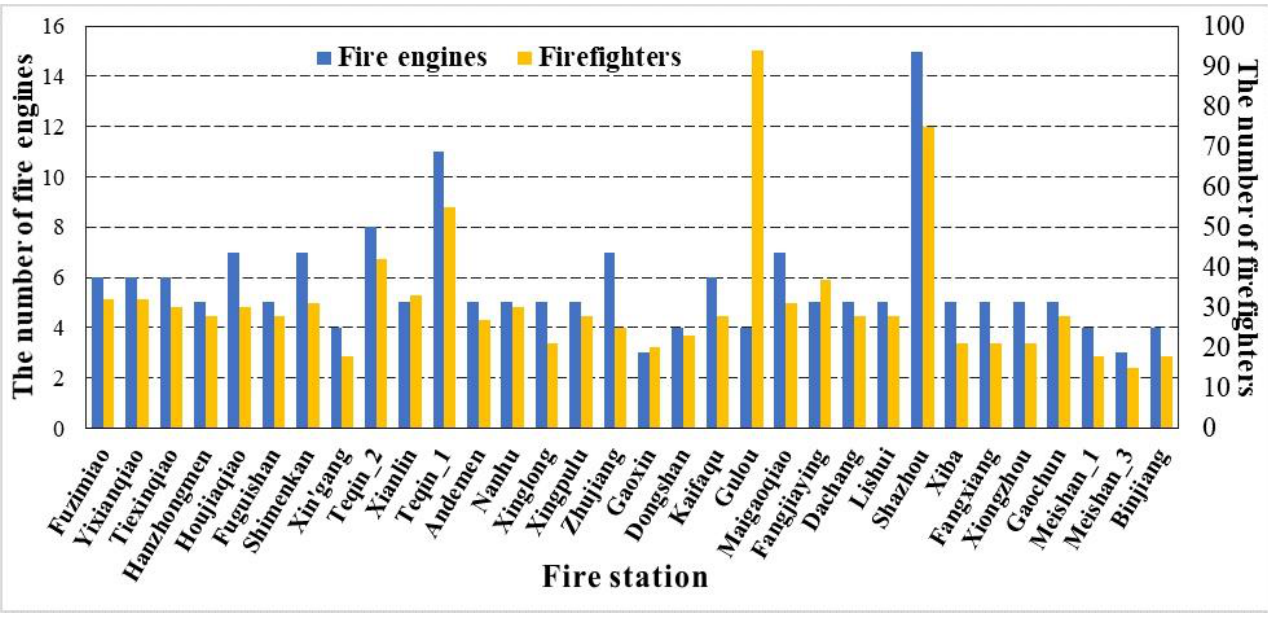
Figure 8. The number of firefighters and fire engines at each fire station in Nanjing, China. Another objective of this study is to explore the spatiotemporal pattern of accessibility and its critical impact factors are discussed. According to the W pattern of accessibility over time, the percent change of uncovered fire incidents and the average travel time change at each fire stations in non-rush and rush hours of 1 day are analyzed. Figure 9a displays the percentage of uncovered fire incidents with travel time over the maximum catchment radius at each fire station in non-rush and rush hours in 1 day. It indicates that most of the fire stations in the suburbs have significantly more uncovered fire incidents than those in the urban center and that the percent of uncovered fire incidents increases considerably in rush hours, especially for the Hanzhongmen and Shimenkan fire stations in the urban center and the Dongshan and Kaifaqu stations in the suburbs. Specifically, all 10 fire stations with more than 20% of fire incidents not being covered were in the suburbs, with the uncovered fire incidents at Hanzhongmen, Shimenkan, Dongshan, and Kaifaqu fire stations increasing by 11.05%, 5.85%, 8.17%, and 6.67% in rush hours, respectively. Hanzhongmen experienced the greatest percent increase in uncovered fire incidents in rush hours and the greatest accessibility decline ratio, as shown in Figure 7. Figure 9b presents the average travel time of fire stations in non-rush and rush hours. It shows that fire stations in the suburbs need more travel time than those in the urban center and that the travel time increase of fire stations in the urban center is relatively higher than in the suburbs during rush hours. Furthermore, Hanzhongmen, Dongshan, Shimenkan, and Kaifaqu are the four fire stations with the greatest travel time increases, 4.3, 4, 3.6, and 3.5 min, respectively, during rush hours, and they are the four with the greatest accessibility decline ratios, as shown in Figure